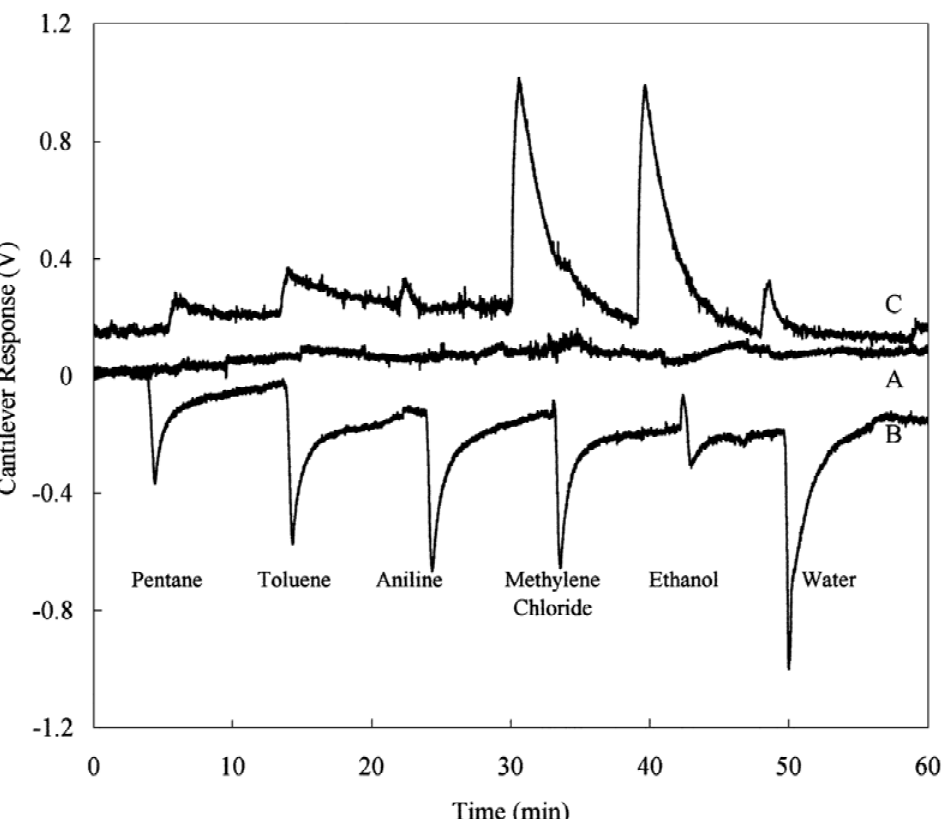
Figure 7. Cantilevers ( A ) treated with Aqua regia; ( B ) coated with gold, removed from one side by a focused ion beam and ( C ) coated with gold and thin films of polymeric chromatographic stationary phases, removed from one side a focused ion beam (reprinted with permission